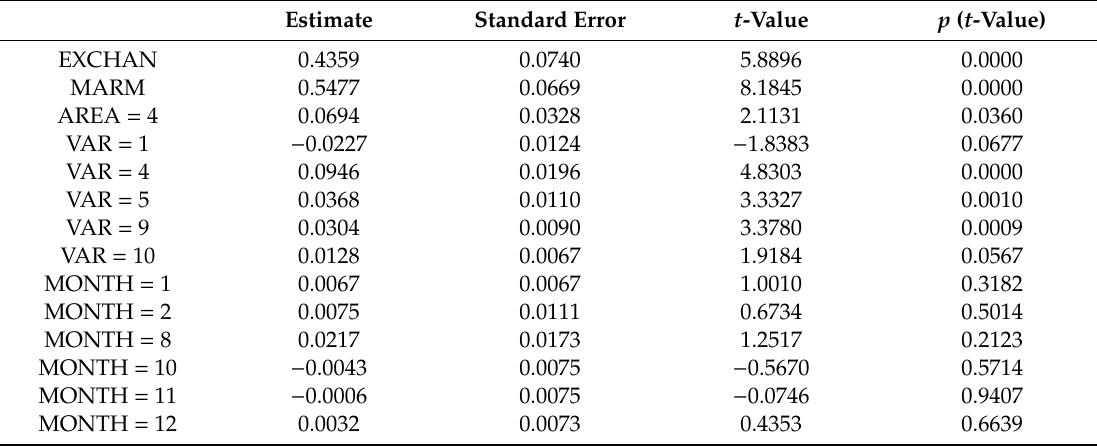
Table 4. Regression coe ffi cients for the model of the field prices of mandarins (all variables).